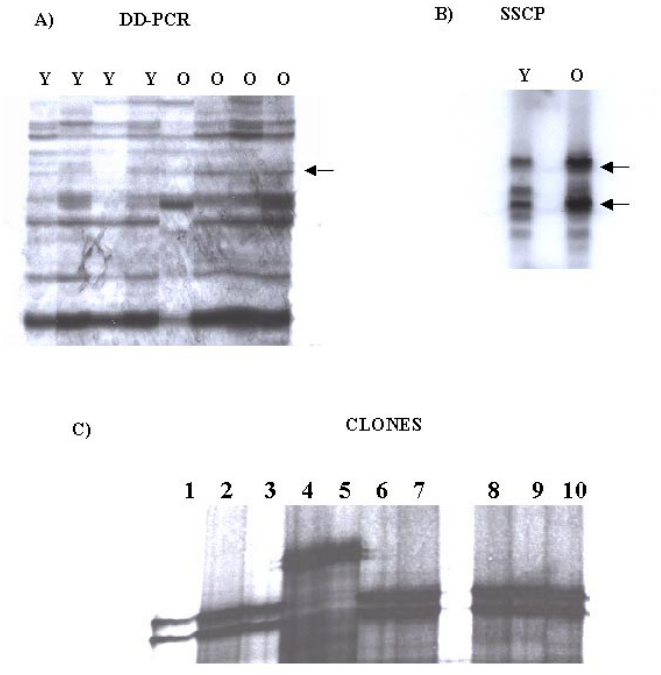
FIGURE 3. Eliminating false positives. (A) DD-PCR autoradiography of the samples analyzed. An area of the gel containing a more prominent band was cut as well as an equivalent area of less prominent band. Ten cycles of radiolabeled PCR were carried out using the cDNA extracted from these two areas. (B) Autoradiography of the SSCP gel shows the two cDNA strands, which are more prominent in the PCR amplification. The more prominent cDNA strand was extracted from the SSCP gel and was then amplified by another ten cycles of PCR and cloned into a TA-cloning plasmid. (C) Analyses of the clones revealed that the majority of them had the same DNA conformation. Therefore, one of these clones was sequenced and used as a probe for the Northern blot, which confirmed the DD-PCR